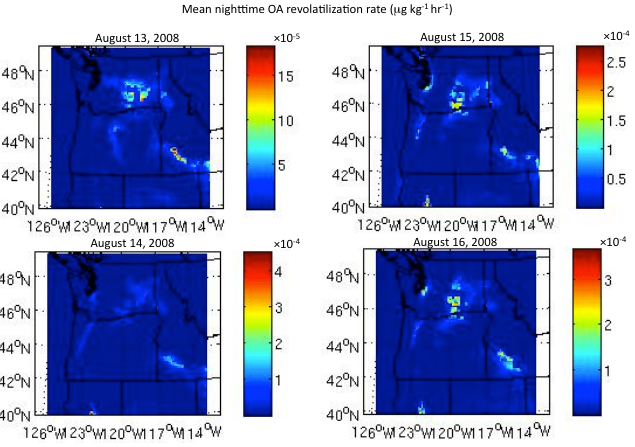
Fig. 10. Zoom-in on the Pacific Northwest to demonstrate spatial and temporal variability of NO 3 OA loss in this lower-NO 3 -concentration region.